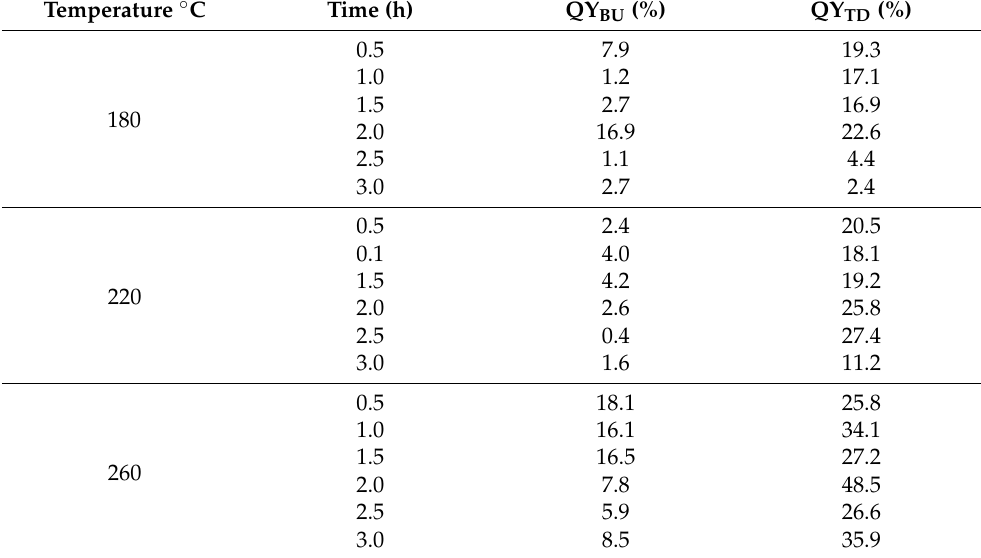
Table 1. Calculated quantum yields for both synthesis methods and varying HTC conditions. QY was calculated with quinine sulfate as a standard diluted to 260 nm UV-VIS measured wavelength to match CD